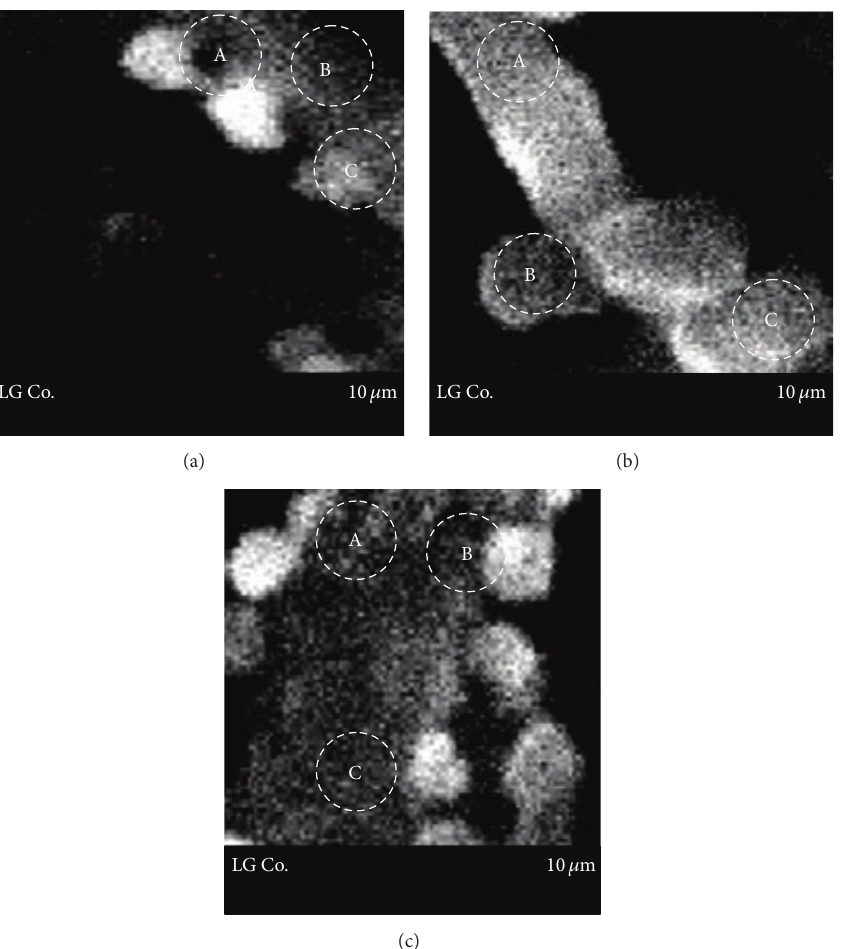
Figure 3: SEM analyses of steps of development of a spore as MO in a SC in Tijuana at (a) one day, (b) three days, and (c) six days